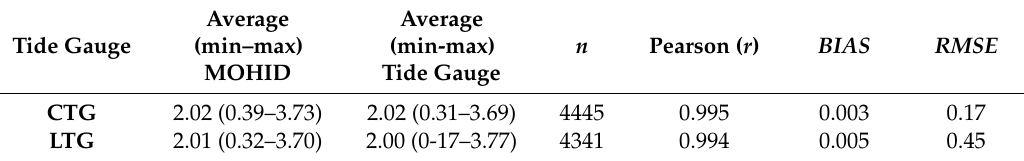
Table 2. Water level. Data summary and results of statistics used to assess the level of agreement between measured data and modelling results. n —number of observations; r —correlation coe ffi cient; BIAS —Average bias; RMSE —Root mean square